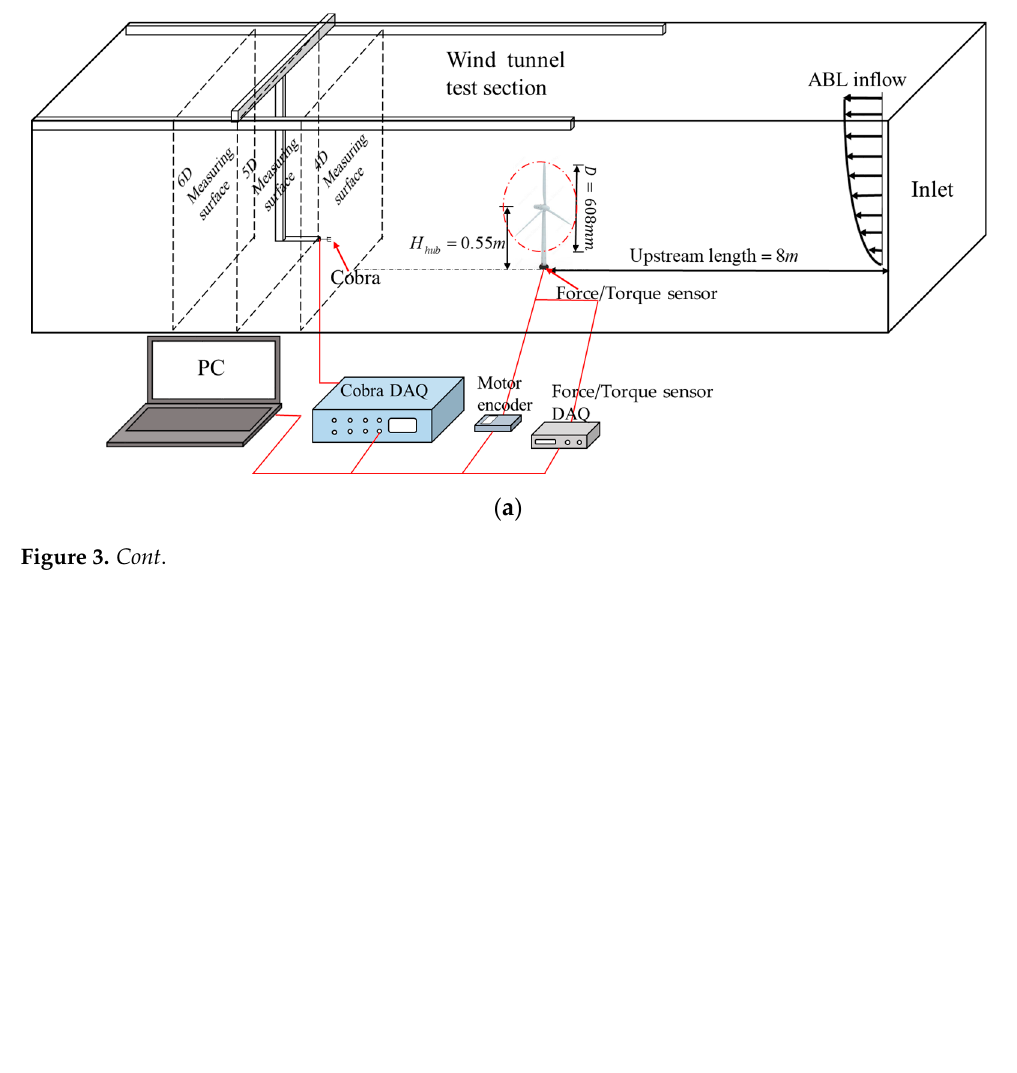
Table 3. The performance parameters of the measuring equipment.